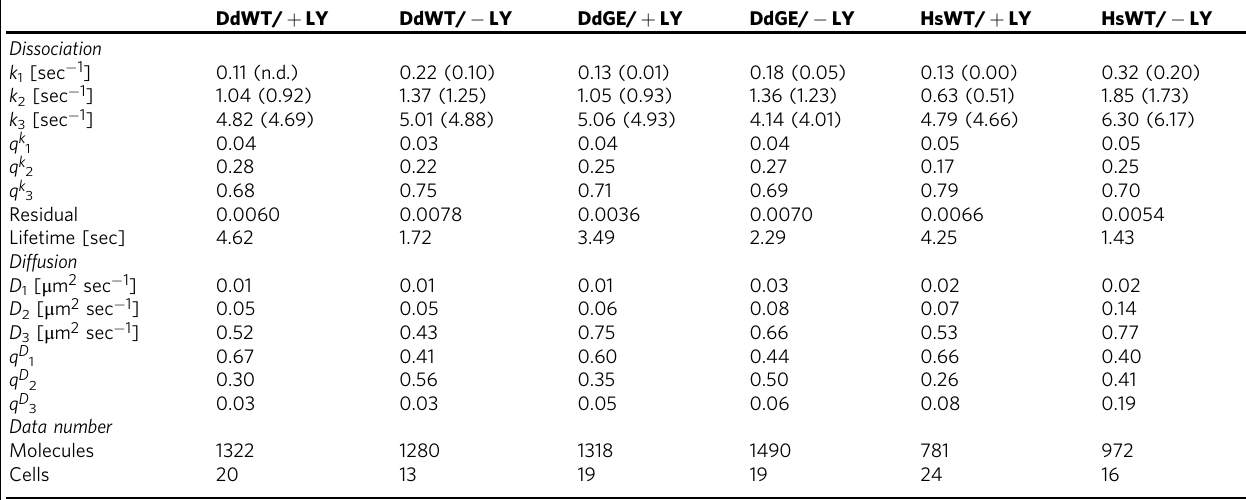
Table 1 Single-molecule measurements of membrane-dissociation kinetics and diffusion coef fi cients DdWT/ + LY DdWT/ − LY DdGE/ +